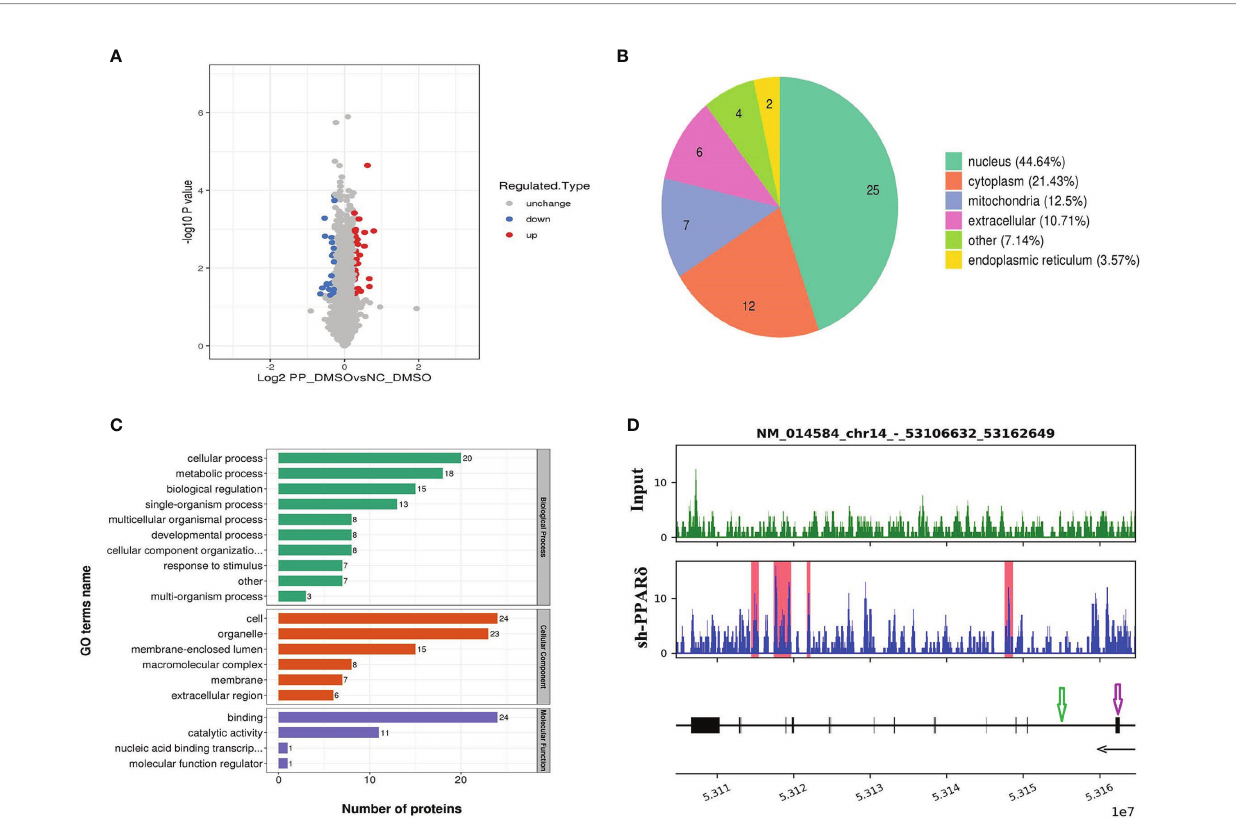
FIGURE 5 | Identi fi cation of ERO1A as a direct target gene by mass spectrometry analysis and ChIP-Seq. (A) Volcano plot showing differentially expressed proteins between the knockdown and control groups. The upregulated and downregulated proteins (P < 0.05 for both) are shown in red and blue, respectively. Gray represents no signi fi cant change in the expression level. (B) Differentially expressed proteins ’ subcellular localization. (C) Functional categorization by Gene Ontology (GO) analysis of the differentially expressed proteins between knockdown and control cells. The GO terms among the three main categories of GO classi fi cation (biological process, cellular component and molecular function) are revealed. The x axis represents the number of proteins in a particular GO term within the main category. (D) ChIP analysis shows that PPAR d as a transcription factor binds to the intron sites of ERO1A (Gene ID number: 014584) which are highlighted with the red rectangle in the lower panel. The tracks below the lower panel are for the annotations of the chromosomal region of ERO1A. Exon is indicated in purple arrow while Intro in green arrow. The black arrow presents the Transcriptional orientation. Numbers below the black arrow denote chromosomal positions in ERO1A. The binding sites are located between